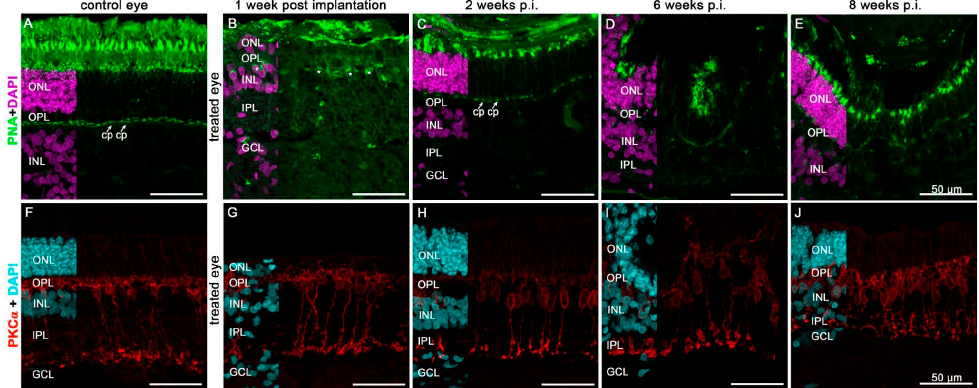
Figure 8. Expression of the cone photoreceptor (peanut agglutinin, PNA) ( B – E ) and the rod bipolar (PKC α ) ( G–J ) markers in the neuroretina underlying the hRPE cell implant followed up to 8 weeks. ( A , F ) are images of control eyes to demonstrate specificity of the staining. Immunofluorescence analysis of the given marker and its appropriate color is shown. Nuclear staining was performed by DAPI (purple in A – E and blue in F – J ). Asterisks in B mark cone cell bodies that were slightly dislocated in the INL due to retinal detachment. Cp = cone pedicles, ONL = outer nuclear layer, INL = inner nuclear layer, OPL = outer plexiform layer, IPL = inner plexiform layer, GCL = ganglion cell layer.